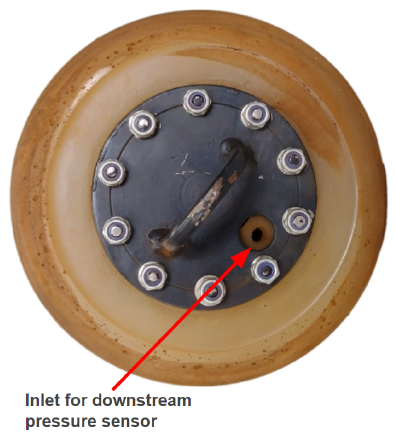
Figure 17. Front and rear views of Prototype PIG 2. Front view.